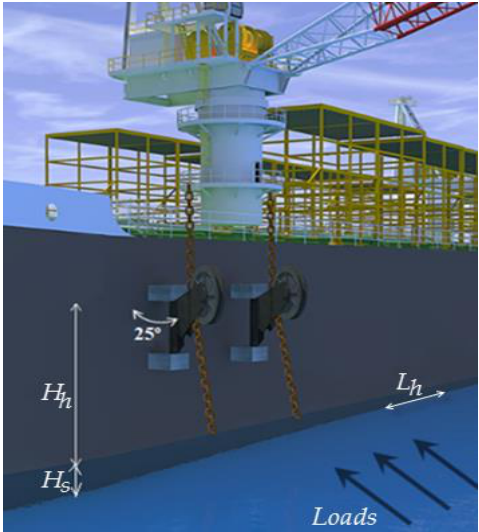
Figure 2. Dimensions of the hull based on Floating, Production, Storage, and Offloading (FPSO) models operating in Campos’s basin.